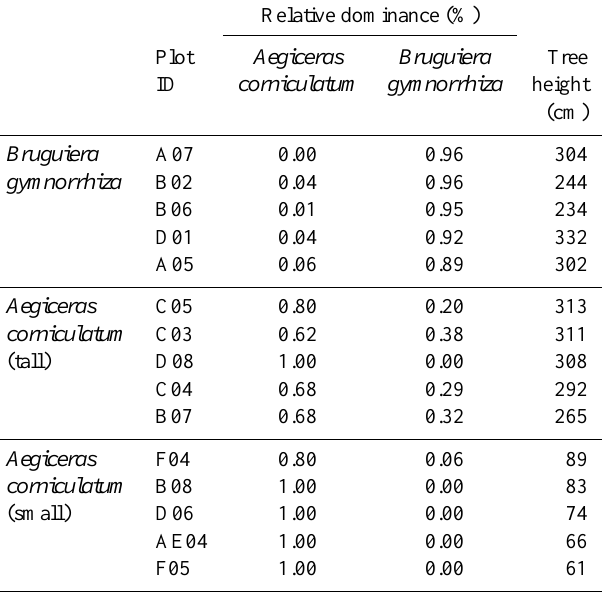
Table 1. Relative dominance and average height of A. corniculatum and B. gymnorrhiza in sample plots used to define mangrove classes for supervised classification (maximum likelihood classification) in ZMNNR, Gaoqiao,